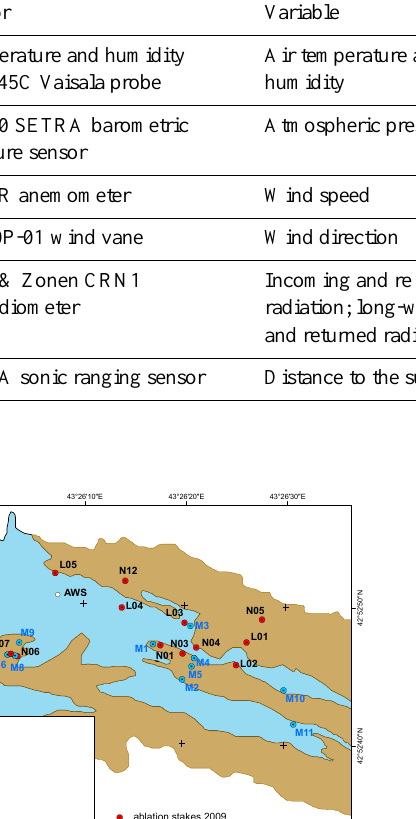
Table 1. Details of the sensors used on Djankuat and Zopkhito glaciers for monitoring meteorological parameters. Sensor Variable Height above the surface (m)